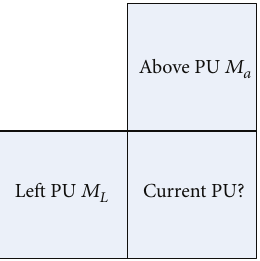
Figure 3: Neighboring modes of current PU.